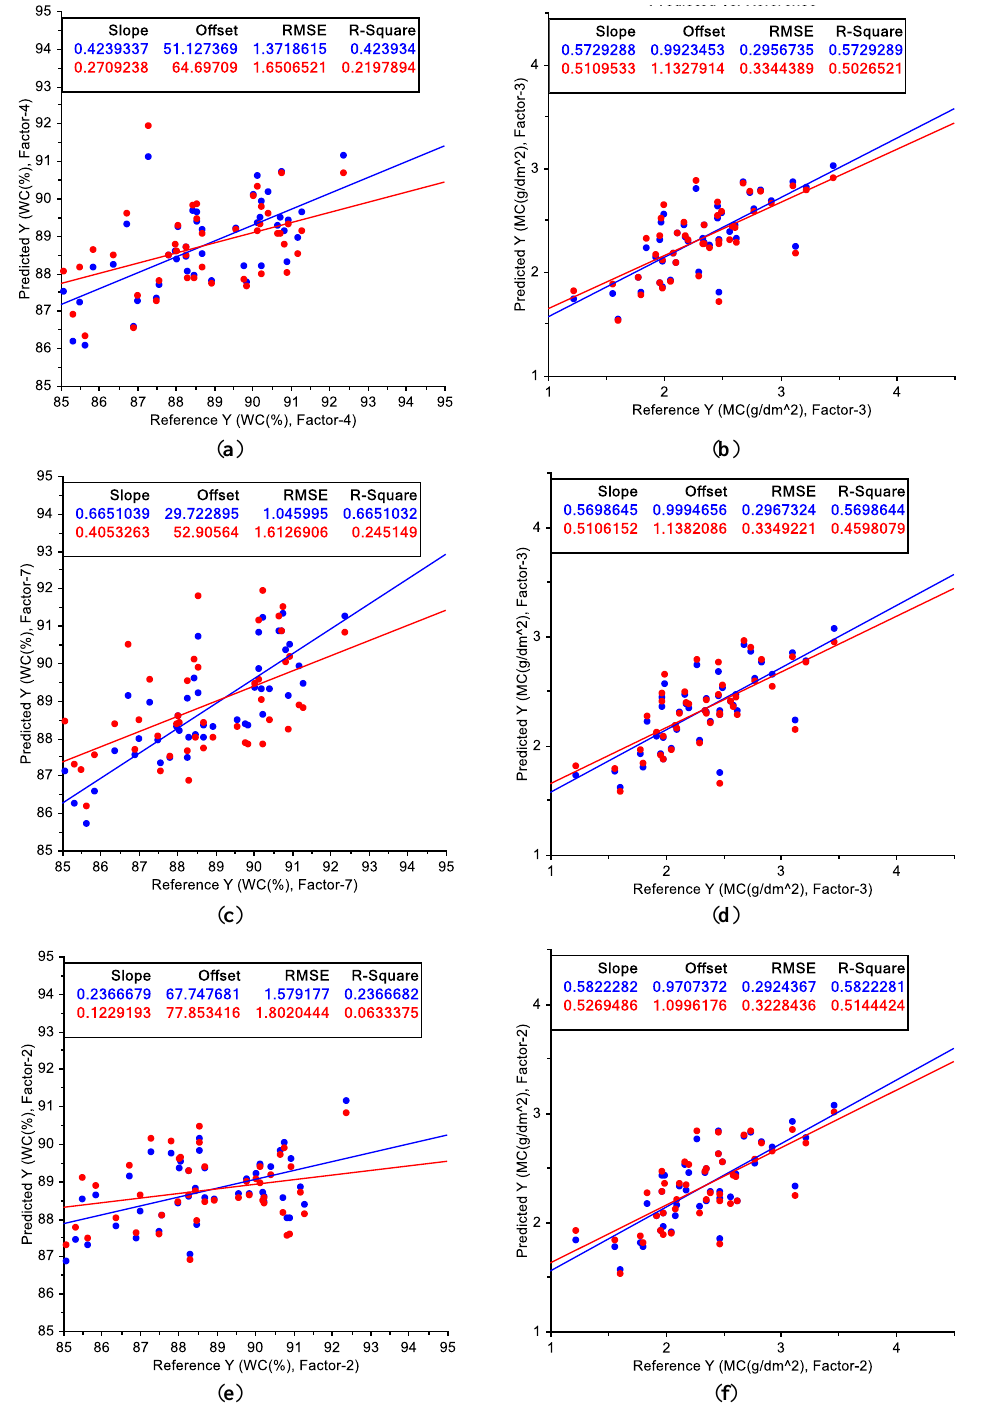
Figure 7. PLS regression for wavelength and water status. ( a ) RAW and WC; ( b ) RAW and MC; ( c ) LOG and WC; ( d ) LOG and MC; ( e ) DIFF and WC; ( f ) DIFF and MC. RMSE: root mean squared error. R-Square: coefficient of determination (blue denotes the calibration and red represents the validation).